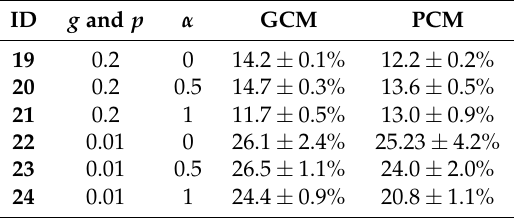
Table 3. Simulation experiments with RL UAV control. Mean and standard deviation are computed from the results of 3 runs of each simulation. Soft Actor Critic (SAC) is an algorithm that produces a stochastic policy, a single run would not be enough to evaluate the policy. ID g and p α